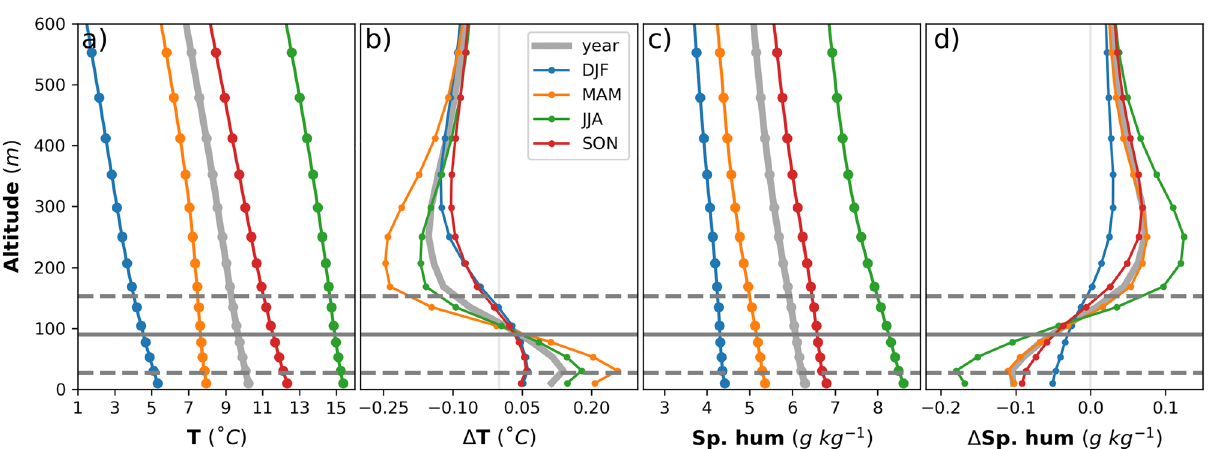
Figure 3. Annual mean difference between the CCLM_WF and CCLM in ( a ) 10 m wind speed and ( b ) surface turbulent kinetic energy outside and inside the wind farms for the prevailing wind directions of 200–280° in 2008–2017. Root mean square errors (RMSE) and mean differences (MD) over the wind farm areas in 2008– 2017 are given in the legend. This figure was created with Matplotlib (Hunter, J. D., Matplotlib: a 2D graphics environment. Computing in Science and Engineering 9, 2007) and Cartopy (Met office, Cartopy: a cartographic python library with a matplotlib interface. Exeter, Devon, https:// scito ols. org. uk/ carto py, 2015).